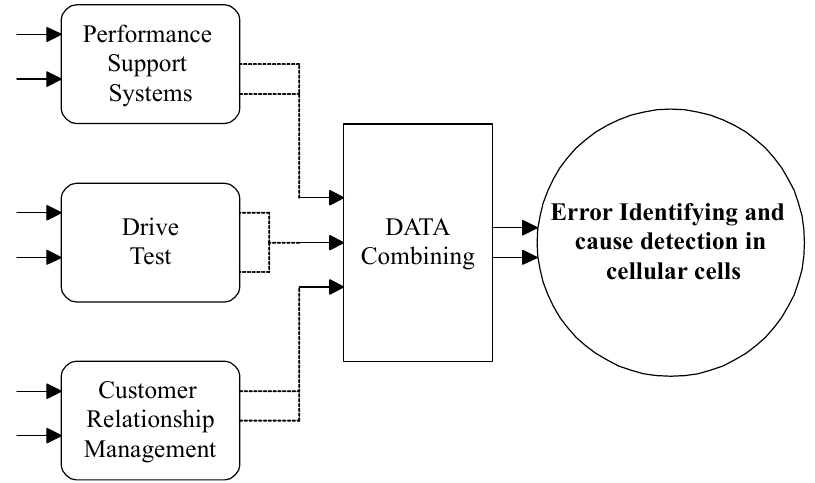
Figure 2. An overall framework of the conducted works in this